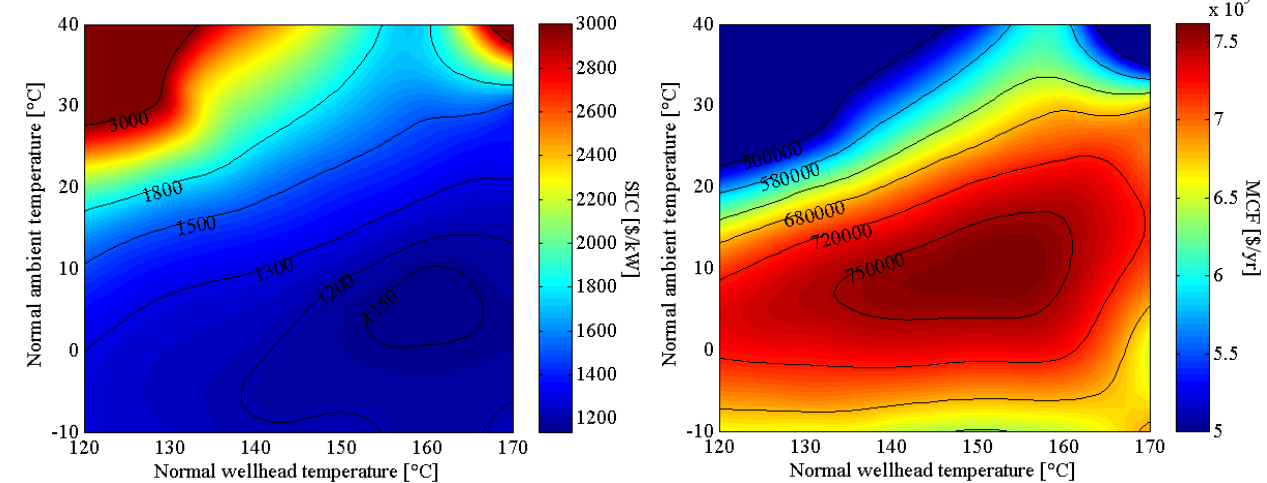
Figure 9. Design-point based on minimizing SIC ( a ) and maximizing MCF ( b ) in temperate